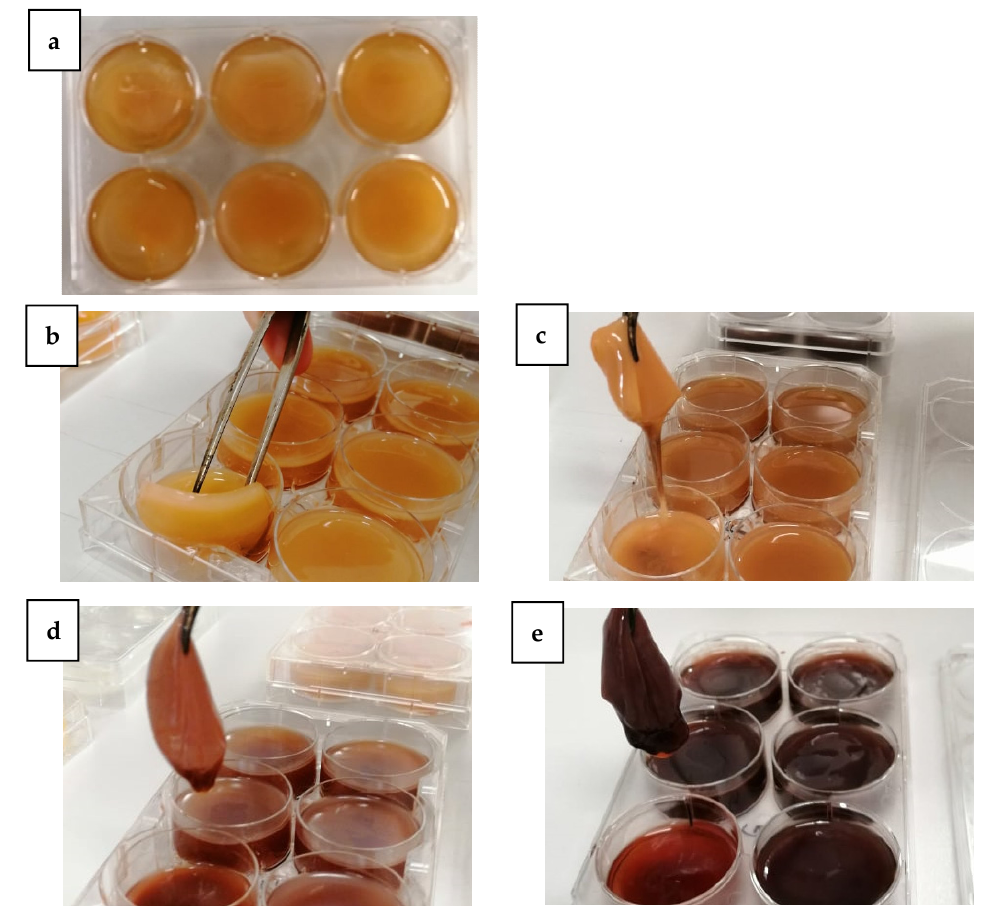
Figure 2. BC produced from ( a ) HS medium, ( b ) HS-C + WGB medium, ( c ) WGB medium, ( d ) HS-C + RGB medium, and ( e ) RGB medium.